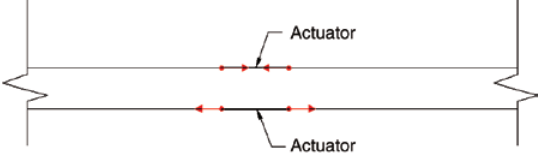
Figure 4: Actuator loading